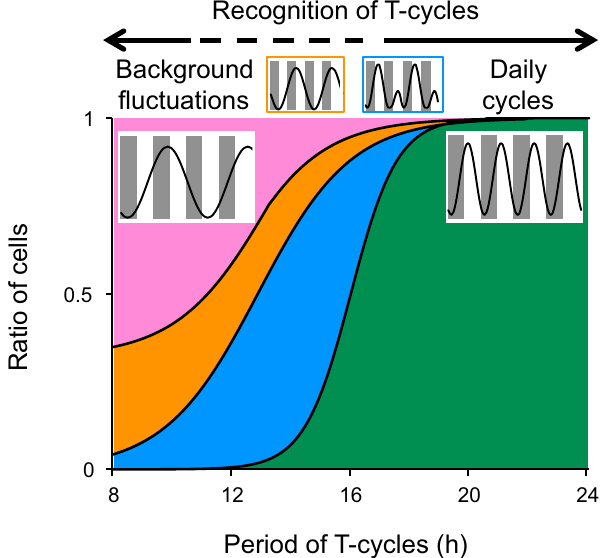
Figure 5. Recognition of T-cycles by a plant composed of cells with heterogeneous circadian properties. Schematic representation of changes in the ratios of cells showing different entrainment habits to environmental T-cycles is shown as a stacked area plot with a hypothetical idea about the recognition of T-cycles by a plant at the top. The four areas represent ratios of cellular rhythms that are entrained (green), incompletely entrained (blue), frequency-demultiplied (orange), and seemingly freerun (pink). Patterns of rhythms in these categories are presented. The plot is based on the data shown in Supplementary Fig.